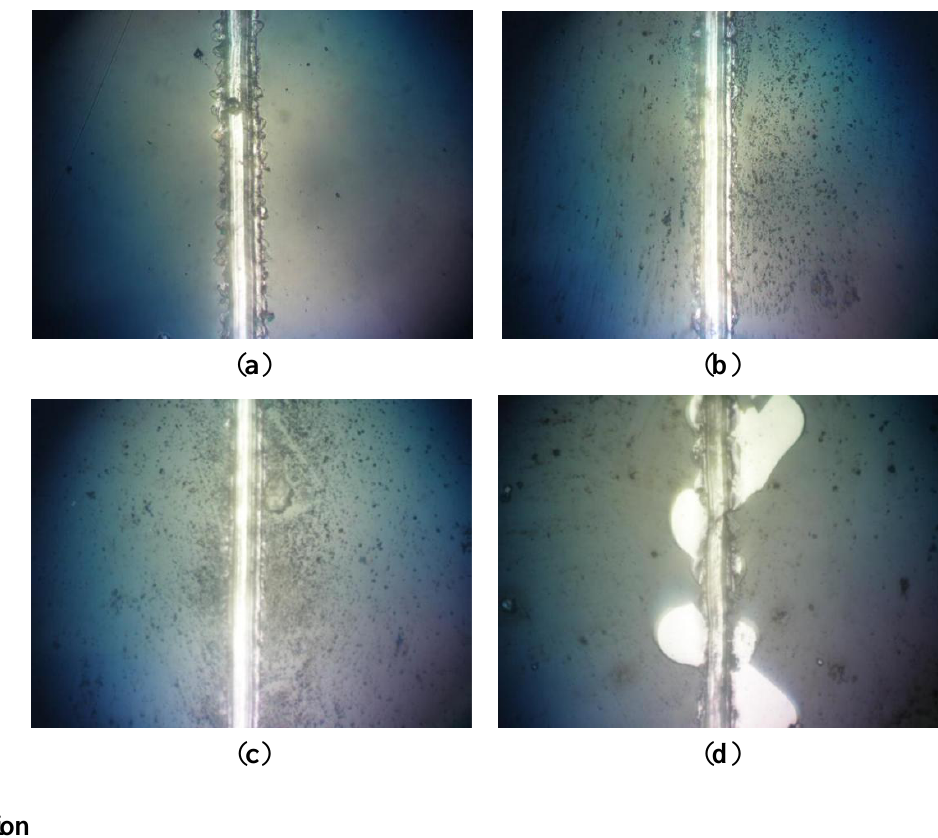
Figure 8. ( a ) Scratch test on sample DLC-Si-316L-04 at 0.5 N load and 500× Magnification; ( b ) Scratch test on sample DLC-Si-316L-06 at 0.5 N load and 500× Magnification; ( c ) Scratch test on sample DLC-316L-01 at 0.5 N load and 500× Magnification; ( d ) Scratch test on sample DLC-316L-09 at 0.5 N load and 500×